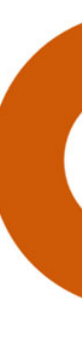
Fig. 2. Awareness of Units location.